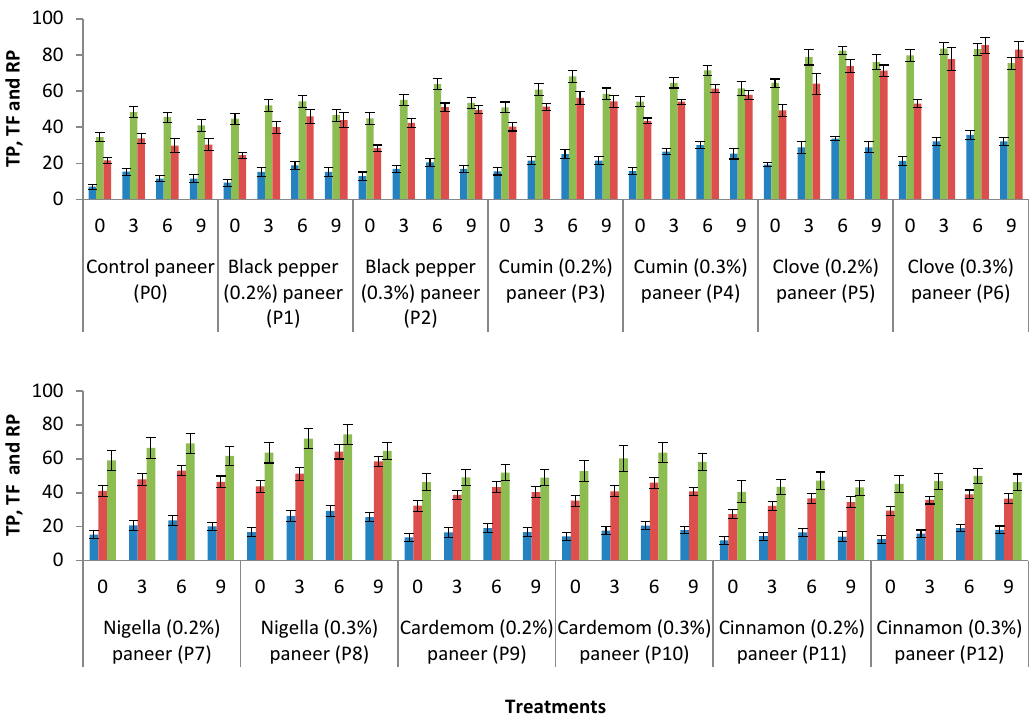
Figure 4. Total phenolics (TP, means ± SD, mg GAE/100 g) (blue bar), total flavonoids (TF, means ± SD, mg CE/100 g) (red bar), and reducing power (RP, means ± SD, mg TE/100 g) (green bar) of spicy paneer during storage at 5 °C.